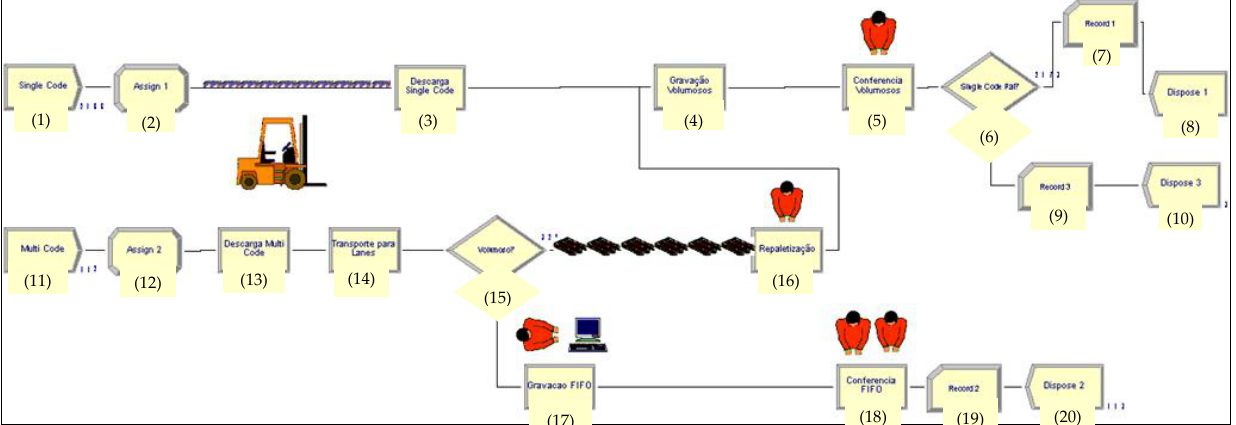
Figure 9. Arena ® Model—Initial state. Legend: (1) Single Code; (2) Assign 1; (3) Unloading Single